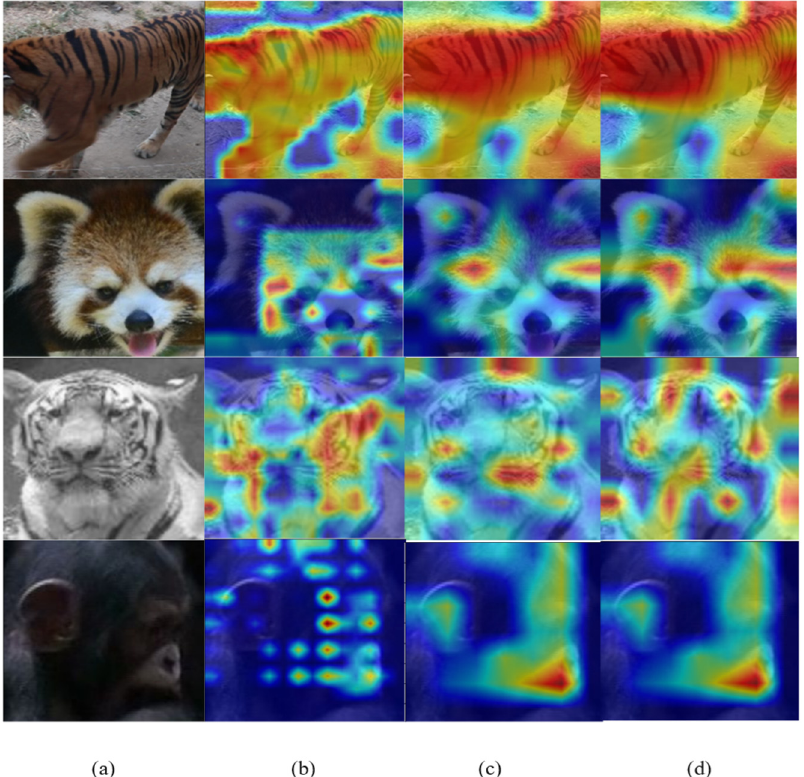
Figure 6. Animal attention hotspot map: ( a ) the original image; ( b ) the attention map after the first CAB block; ( c ) the attention map after the second CAB block; and ( d ) the attention map after the third CAB block.